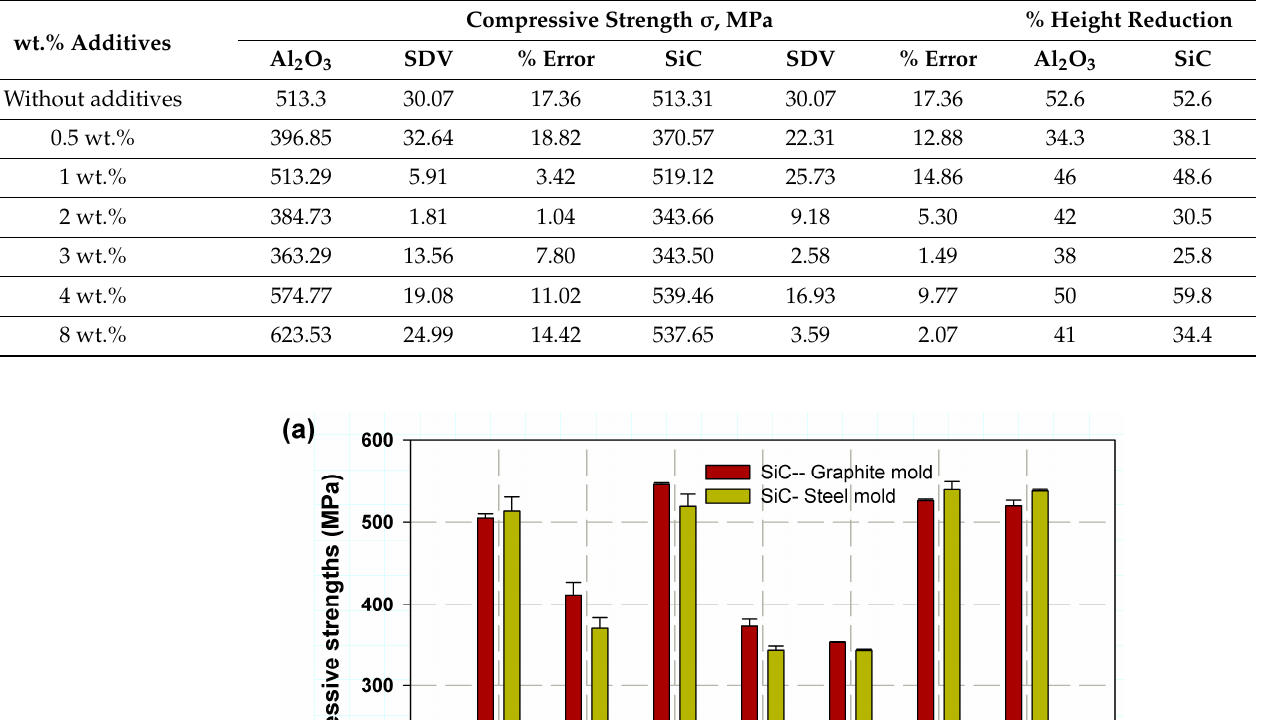
Table 2. Compression test results for (Al 2 O 3 and SiC)/Al-Si-Mg casted in a steel mold.